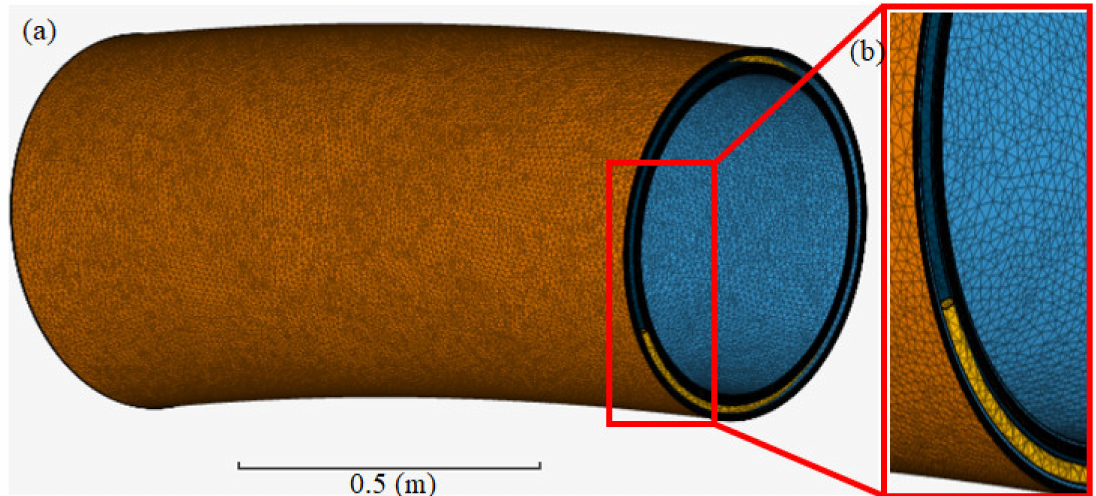
Figure 6. Mesh model for the marine hose in Simscale Platform showing ( a ) the full mesh model and ( b ) the magnified mesh detail.